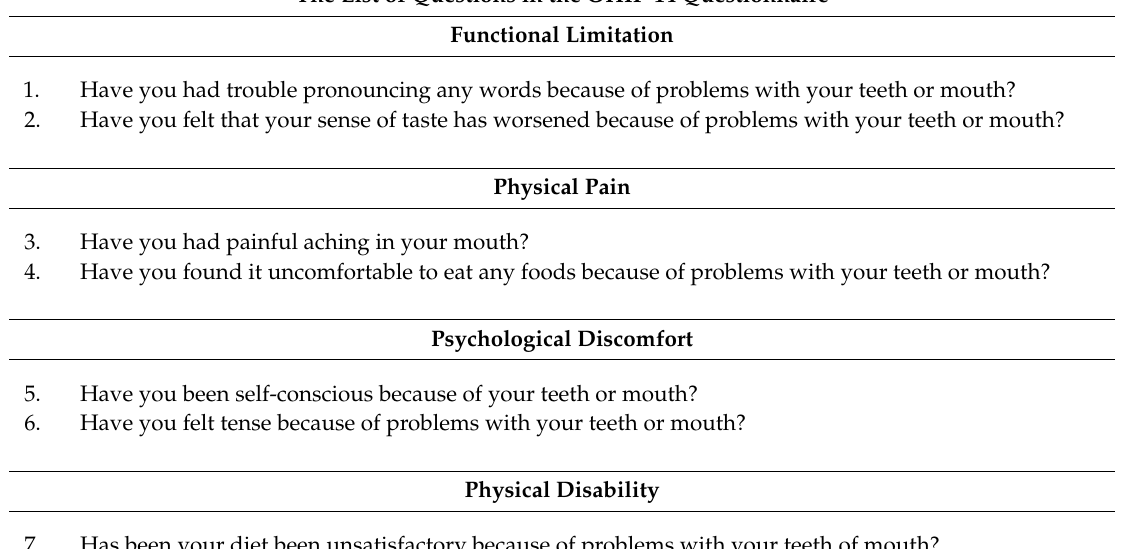
Table 3. The list of questions in the 14-item Oral Health Impact Profile (OHIP-14) Questionnaire [17]. The List of Questions in the OHIP-14